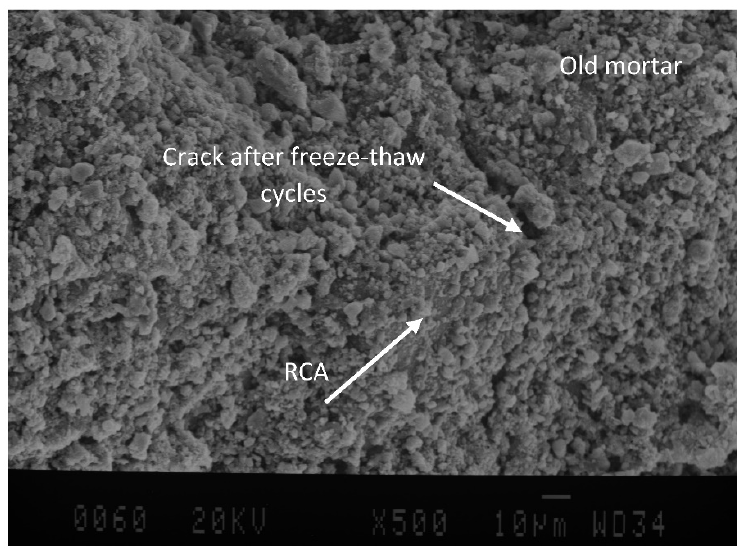
Figure 12. Surface deterioration of recycled concrete aggregates exposure to freeze and thaw cy- cles.